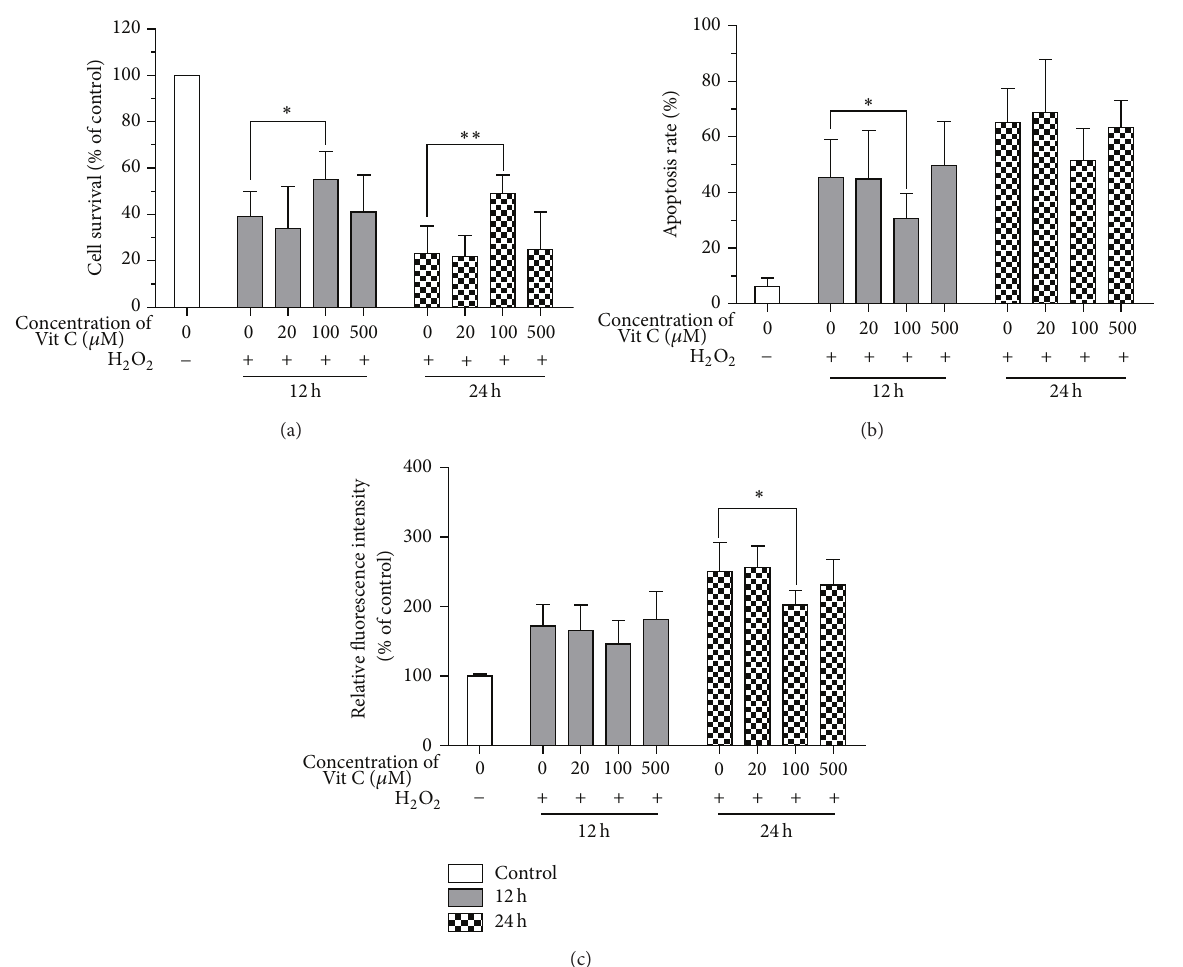
Figure 1: Effects of Vit C on viability, apoptosis, and intracellular ROS of ARPE-19 cells induced by H 2 O 2 . ARPE-19 cells were incubated for 24 h with 0 𝜇 M, 20 𝜇 M, 100 𝜇 M, or 500 𝜇 M of Vit C and then exposed to 100 𝜇 M of H 2 O 2 for 12 h or 24 h. Viability, apoptosis, and intracellular ROS were measured by using MTT assays, TUNEL assays, and DCFH-DA, respectively, as shown in Section 2. Normal ARPE-19 cells which did not undergo treatment were expressed as “control.” Data were expressed as a percentage of cell survival (a), apoptosis (b), and relative fluorescence intensity (c). Bars represented mean ± SD of three independent experiments. ANOVA was performed to analyze the differences statistically. Statistical significance was expressed as ∗ 𝑃 < 0.05 and ∗∗ 𝑃 < 0.01